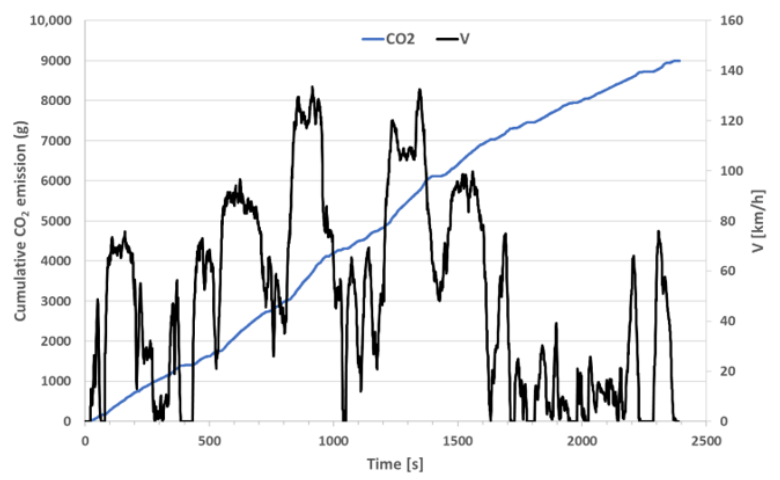
Figure 15. Cumulative CO 2 emission versus vehicle speed in on-road test, petrol propulsion.